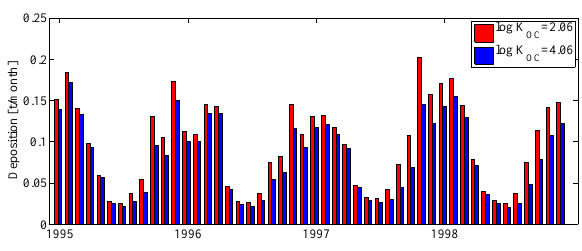
Fig. 7. One-year time series of the latitudinal distribution of daily mean PFOA wet and dry deposition [kg m − 2 s − 1 ].